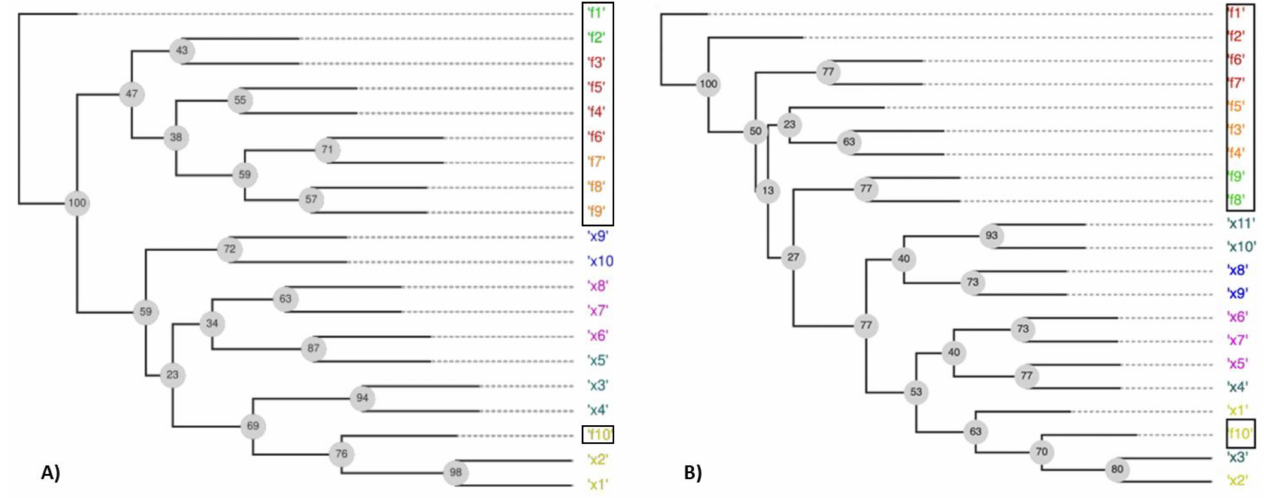
Figure 5. Phylogram and the clusters found: ( A ) for unconstrained DTLZ5 with 10 objectives and ( B ) for constrained DTLZ5 (2,10).